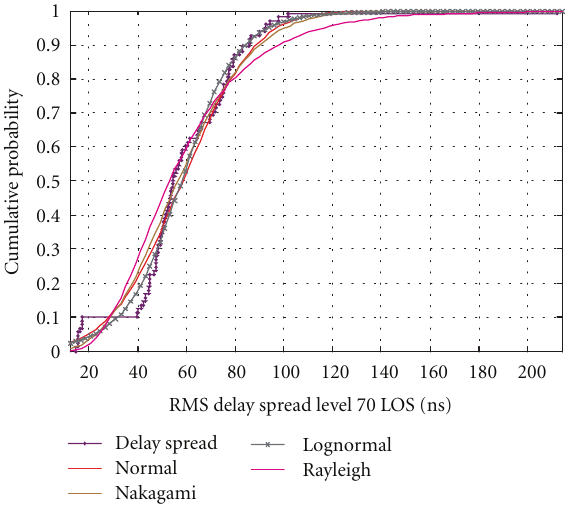
Figure 9: E ff ect of antenna directivity and obstruction on the channel